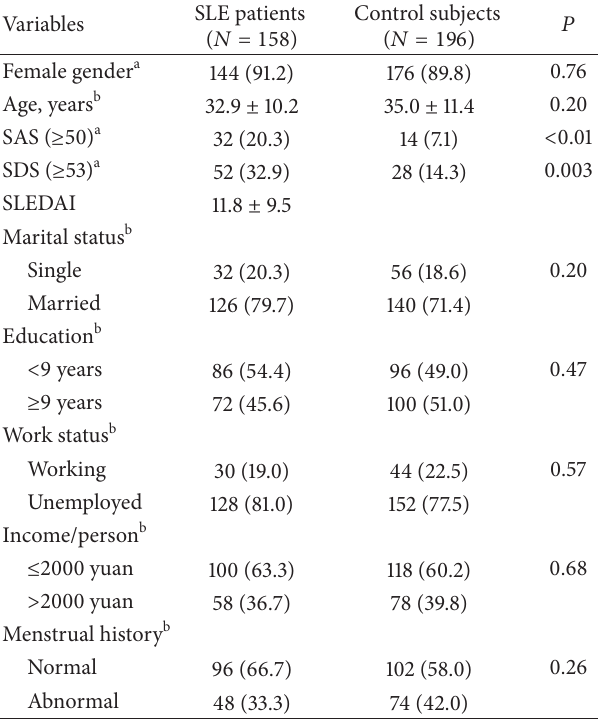
Table 1: Demographic, psychological, and disease characteristics in SLE patients and controls.